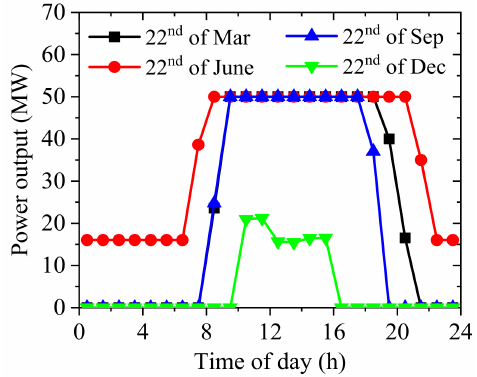
Figure 15. Daily variation of power generation of CSP plant under four different reference